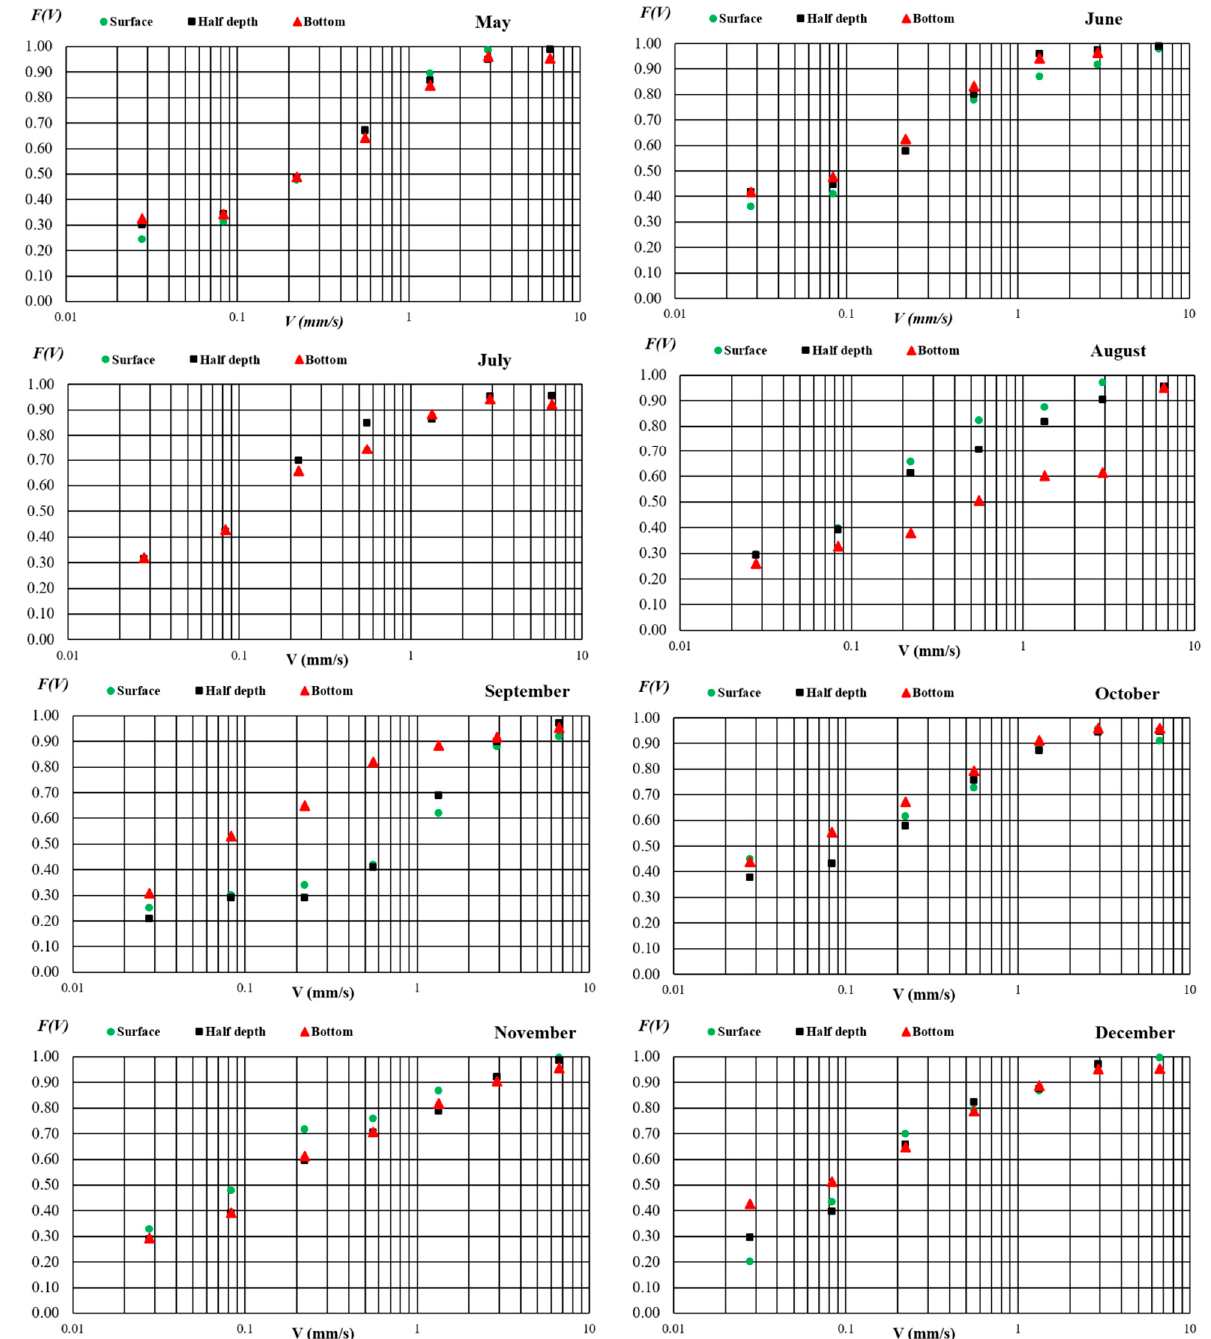
Figure 4. Suspended solids settling velocity distribution functions characteristic of the Lobo reservoir from January to December 2020.